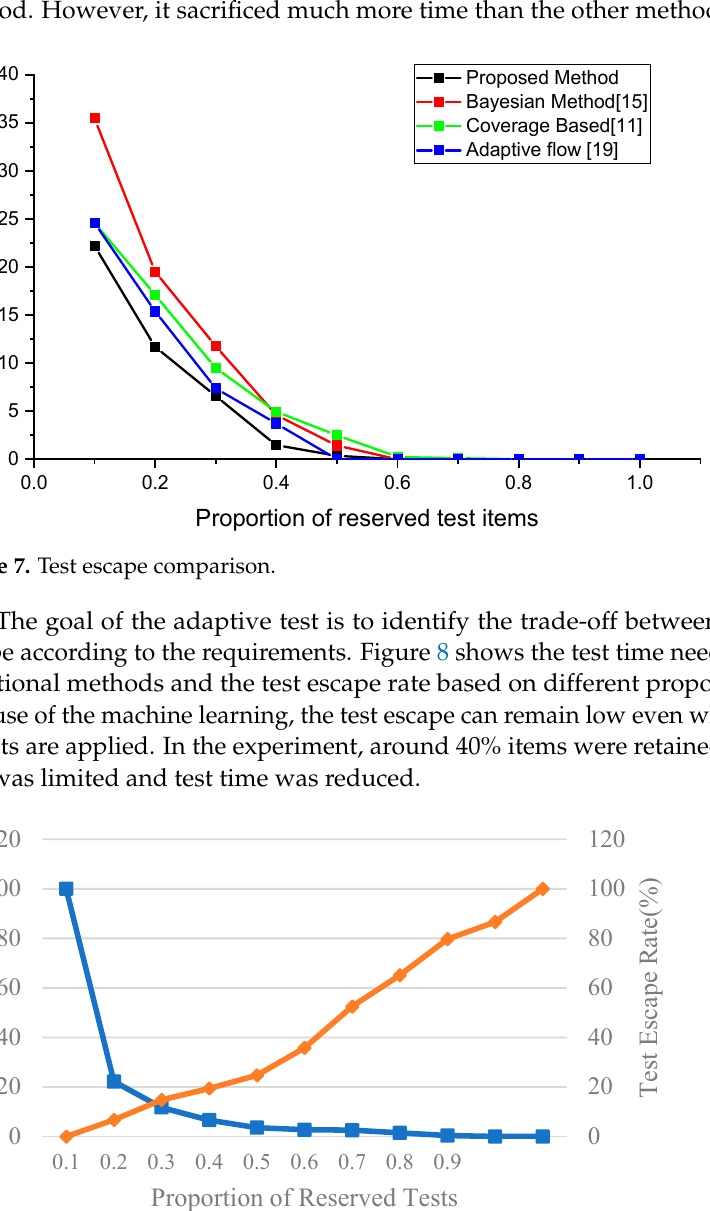
Table 3. Results when using different wafers.